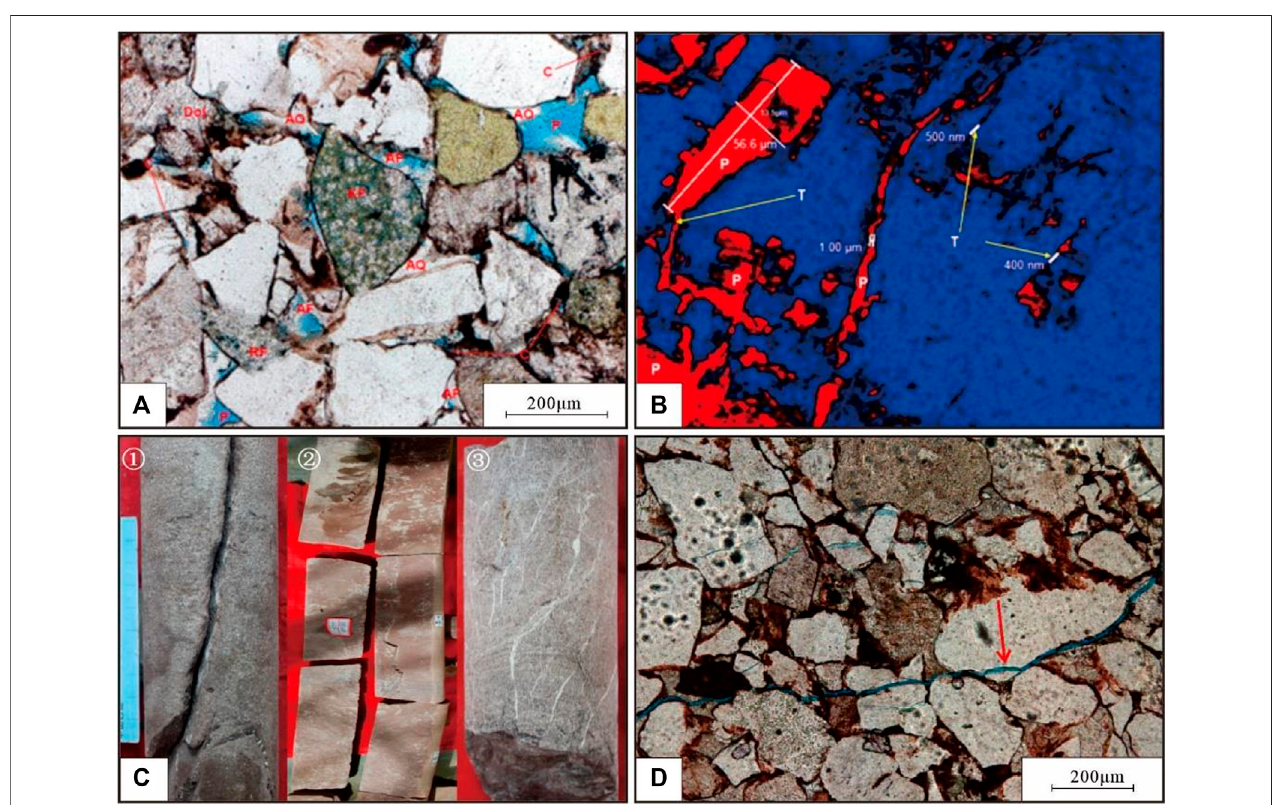
FIGURE3| Fracturecharacteristicsofultra-deepreservoirsintheKeshengas fi eld.Notes: (A) WellK2,6,723.86 m,thereservoirspaceisenlargedbyintergranular dissolution. Autogenic quartz, AQ; Clay minerals, C; Porosity, P; Dolomite, Dol; K-feldspar, KF; Autogenic feldspar, AF; (B) Well K2, 6,706.5 m, Laser confocal, pore diameter 1 – 56.6 μ m, throat 400 – 500 nm. Throat, T; (C) Core with fractures, ① Well K8, 7,368 – 7,368.5 m, high angle fracture half- fi lled, with fracture aperture 0. 5~2 mm; ② Well K13, 7,639.5 – 7,640.4 m, open vertical split longitudinal fracture; ③ Well K2, 6,991.2 – 6,991.4 m, tensile fractures, half- fi lled to fully fi lled by calcite, fracture aperture 1~4 mm; (D) Well K24, 6,506.24 m, fracture often cuts through grains, fracture width 10 – 50 μ